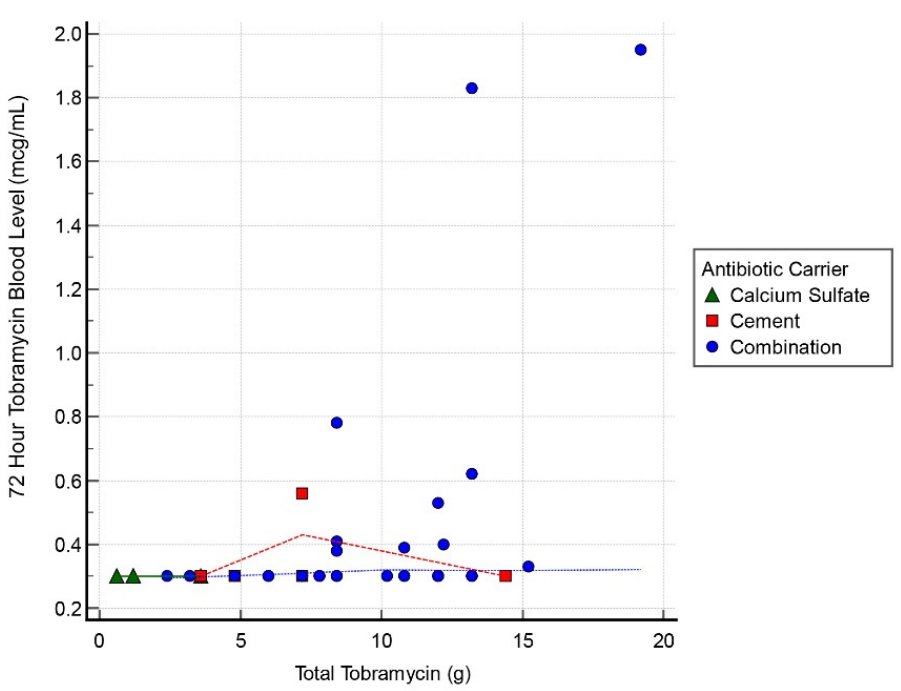
Figure 2. Scatter graph of tobramycin blood level (mcg/mL) and total tobramycin (g) at 48 h inter- val.